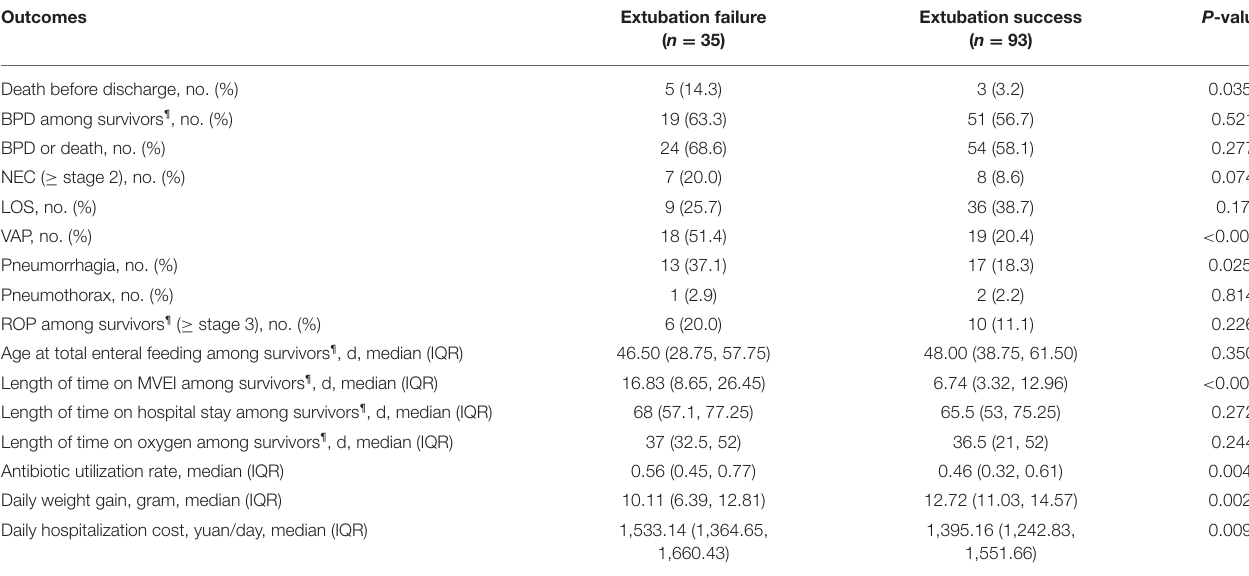
TABLE 3 | Outcomes for 128 preterm infants who had extubation failure vs. extubation success. Outcomes Extubation failure